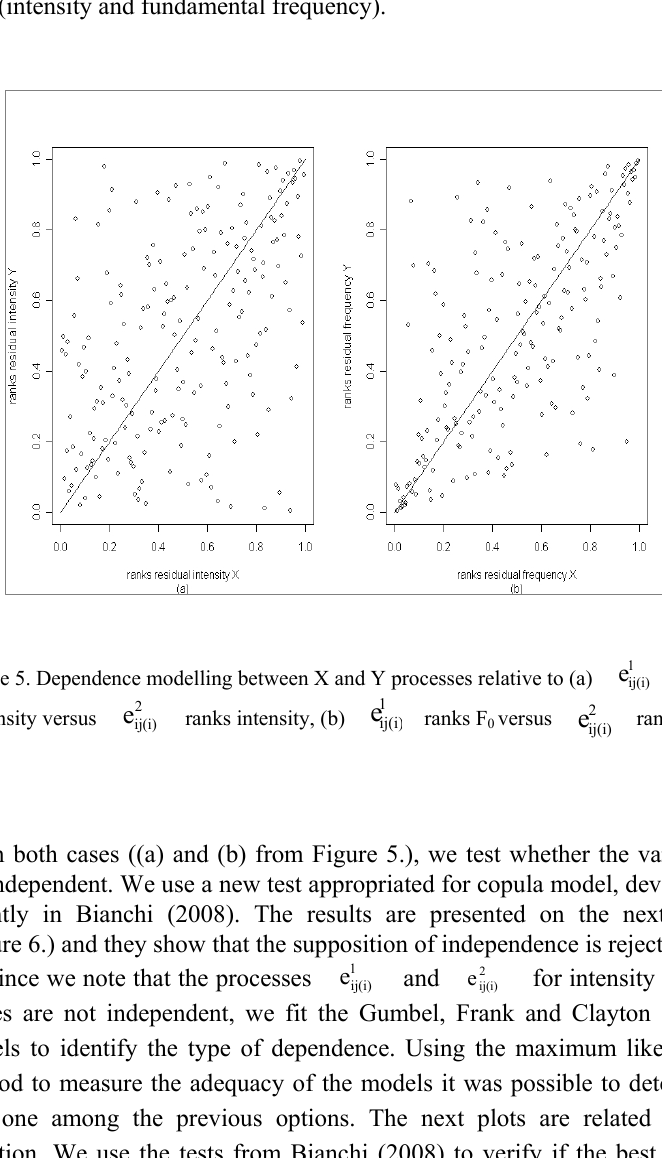
Figure 5. Dependence modelling between X and Y processes relative to (a) intensity versus 2 ij(i) e ranks intensity, (b)